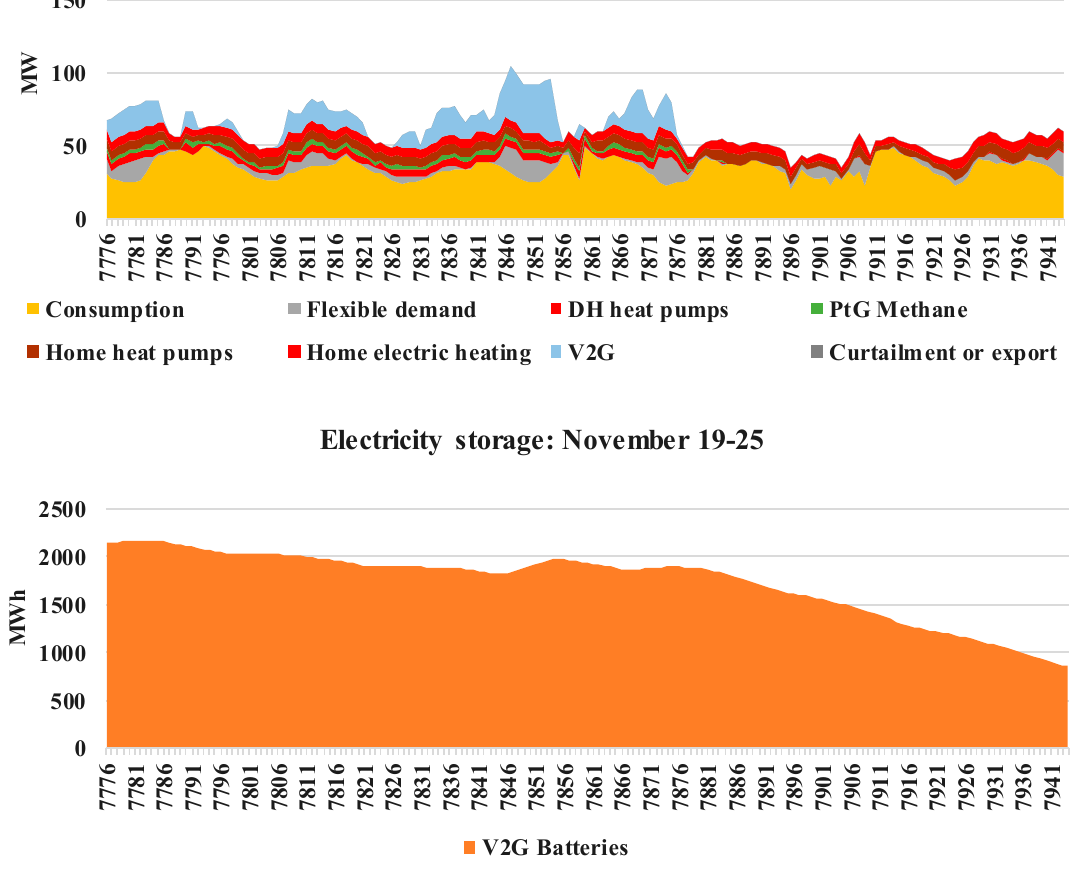
Figure 11. Electricity supply ( Top ), consumption ( Centre ), and storage ( Bottom ) for the second study period: 19–25 November. The end of the week showed the lowest levels of variable RE generation during the year and was the most challenging period for the energy system. However, use of electric storage, thermal power plants, and a small amount of imported electricity was sufficient to satisfy demand. V2G batteries experienced net discharge over the week but still maintained more than 25% capacity.